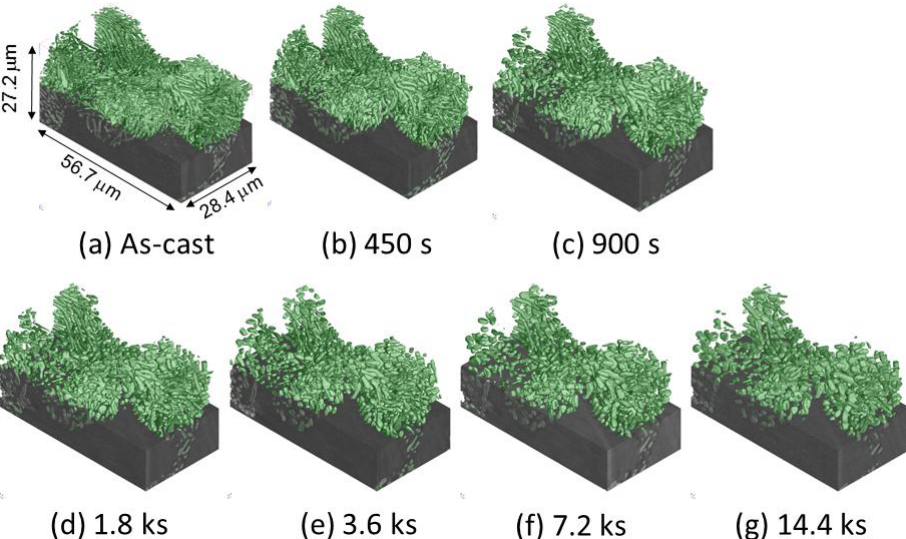
Figure 6. Three-dimensional volume images of eutectic Si-particles in Al-9.8%Si-3ppmP cast alloy. ( a ) As-cast, ( b ) heat-treated at 773 K for 450 s, ( c ) heat-treated at 773 K for 900 s, ( d ) heat-treated at 773 K for 1.8 ks, ( e ) heat-treated at 773 K for 3.6 ks, ( f ) heat-treated at 773 K for 7.2 ks, ( g ) heat-treated at 773 K for 14.4 ks.